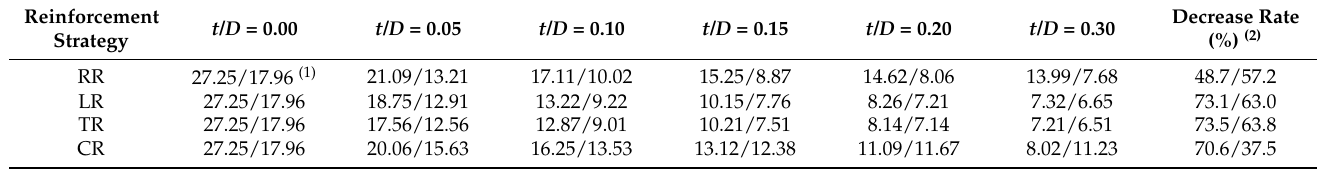
Table 2. The maximum value of horizontal and vertical displacements (in mm).